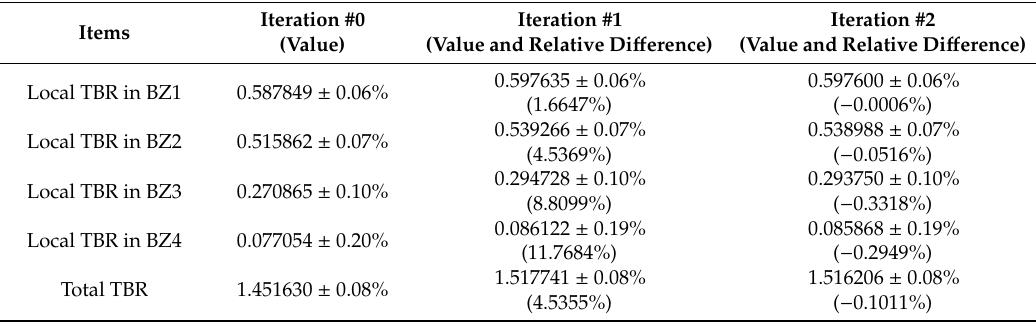
Table 12. TBR variation in the two-way N / TH coupling calculation of the WCCB